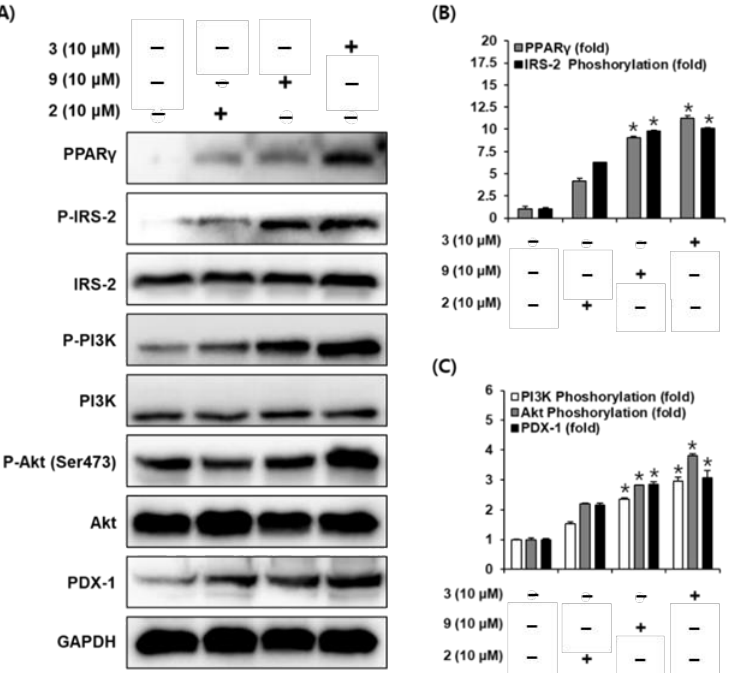
Figure 7. Effect of compounds 2 , 3 , and 9 on the protein expression levels of peroxisome prolifera- activated receptor- γ (PPAR- γ ), P-insulin receptor substrate-2 (IRS-2) (Ser731), IRS-2, P-phosphatidylinositol tor-activated receptor-γ (PPAR-γ), P-insulin receptor substrate-2 (IRS-2) (Ser731), IRS-2, P-phos- 3-kinase (PI3K), PI3K, P-Akt (Ser473), Akt, and pancreatic and duodenal homeobox-1 (PDX-1) in phatidylinositol 3-kinase (PI3K), PI3K, P-Akt (Ser473), Akt, and pancreatic and duodenal homeo- box-1 (PDX-1) in INS-1 cells. ( A ) Protein expression levels of PPAR-γ, P-IRS-2 (Ser731), IRS-2, P- INS-1 cells. ( A ) Protein expression levels of PPAR- γ , P-IRS-2 (Ser731), IRS-2, P-PI3K, PI3K, P-Akt PI3K, PI3K, P-Akt (Ser473), Akt, PDX-1, and glyceraldehyde 3-phosphate dehydrogenase (Ser473), Akt, PDX-1, and glyceraldehyde 3-phosphate dehydrogenase (GAPDH) in INS-1 cells (GAPDH) in INS-1 cells treated or untreated with 10 μM compounds 2 , 3 , and 9 for 24 h. ( B , C ) treated or untreated with 10 µ M compounds 2 , 3 , and 9 for 24 h. ( B , C ) Each bar graph presents Each bar graph presents the densitometric quantification of Western blot bands. * p < 0.05 com- the densitometric quantification of Western blot bands. * p < 0.05 compared to the control (0 µ M), pared to the control (0 μM), Kruskal–Wallis non-parametric test). The data are presented as the Kruskal–Wallis non-parametric test). The data are presented as the mean ± mean ± SEM.